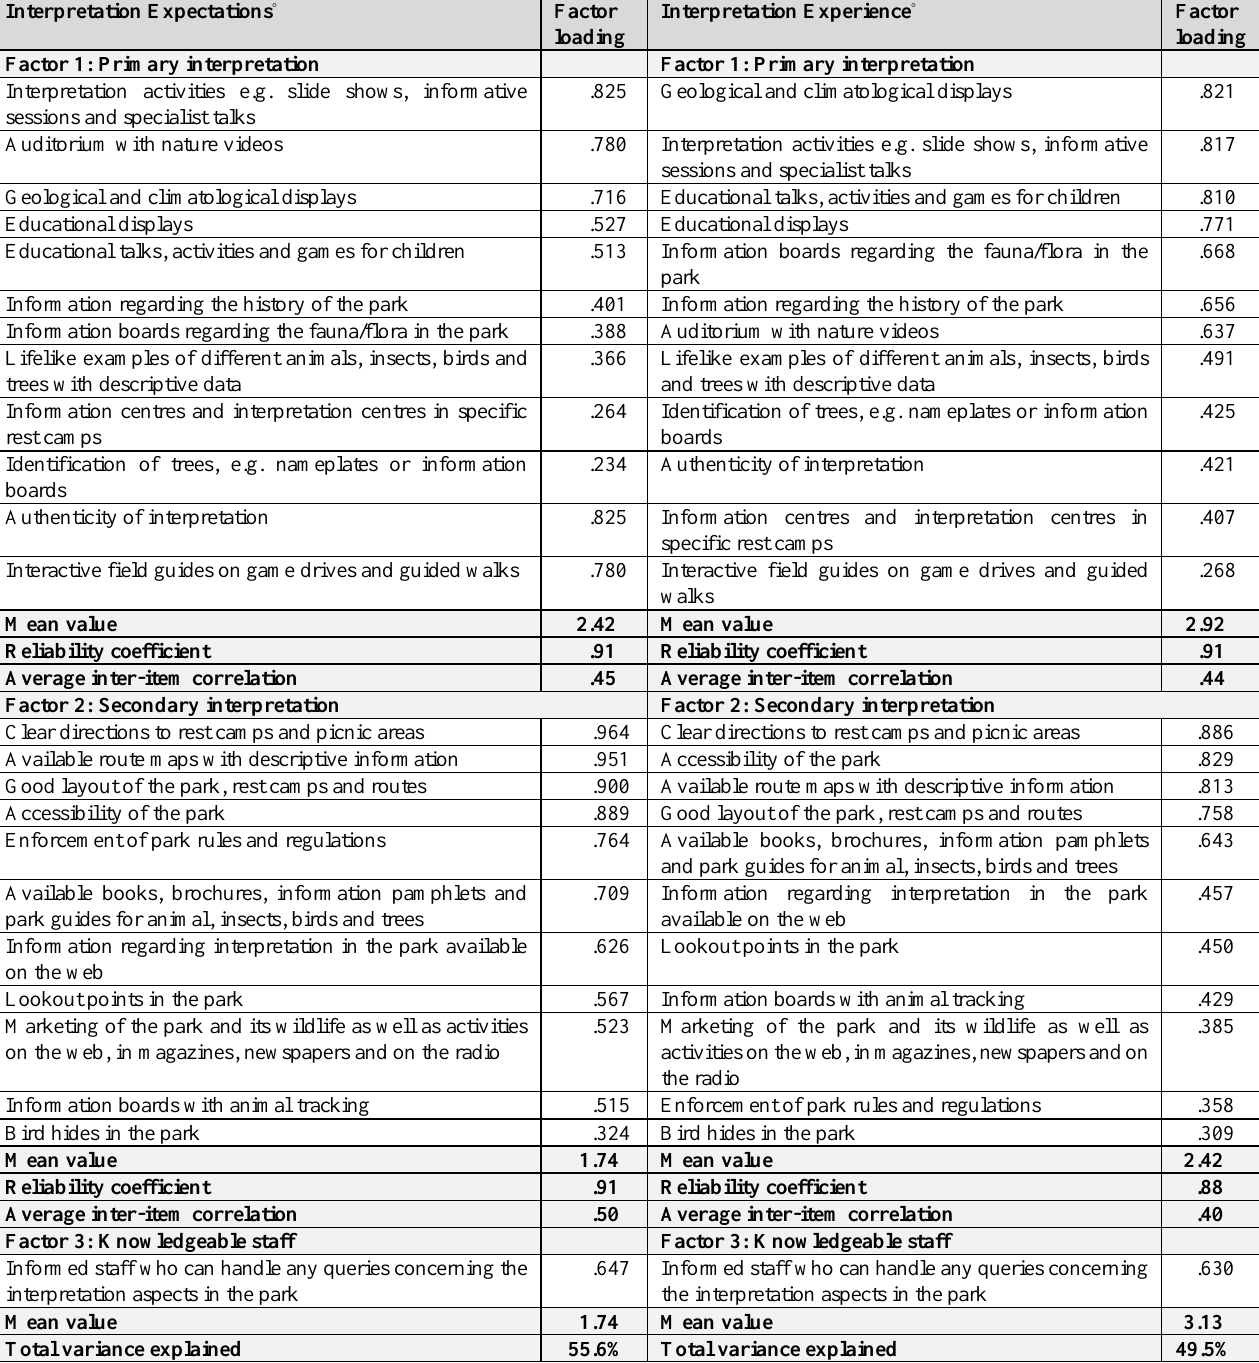
Table 1: Factor analyses for expectations of – and experiences with interpretation services of the Kruger National Park Interpretation Expectations